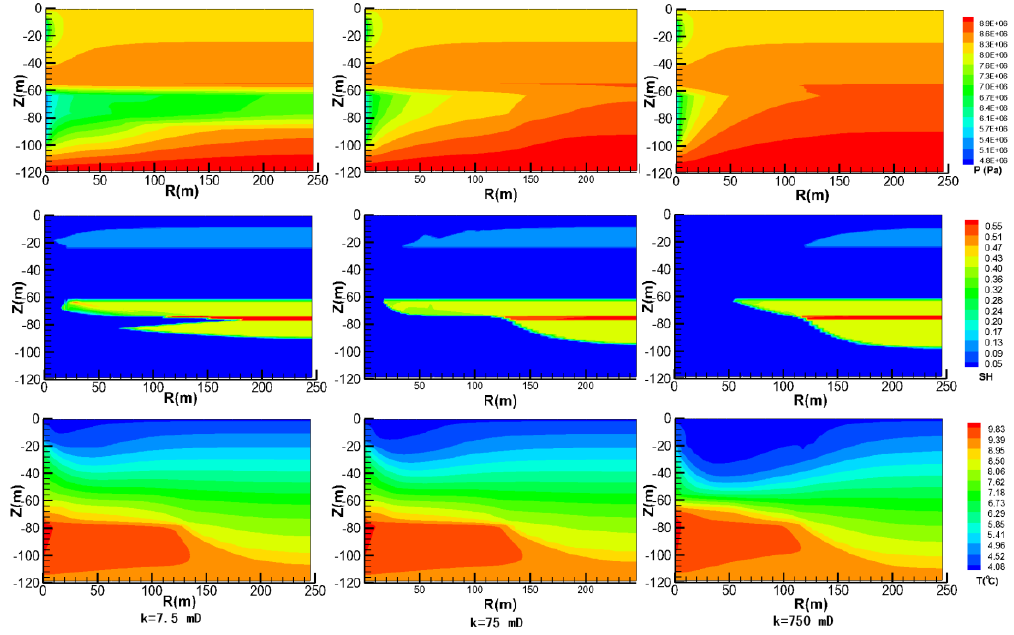
Figure 20. Sensitivity to the intrinsic permeability ( k ): evolution of P , S H , and T distribution at t = 30 years.